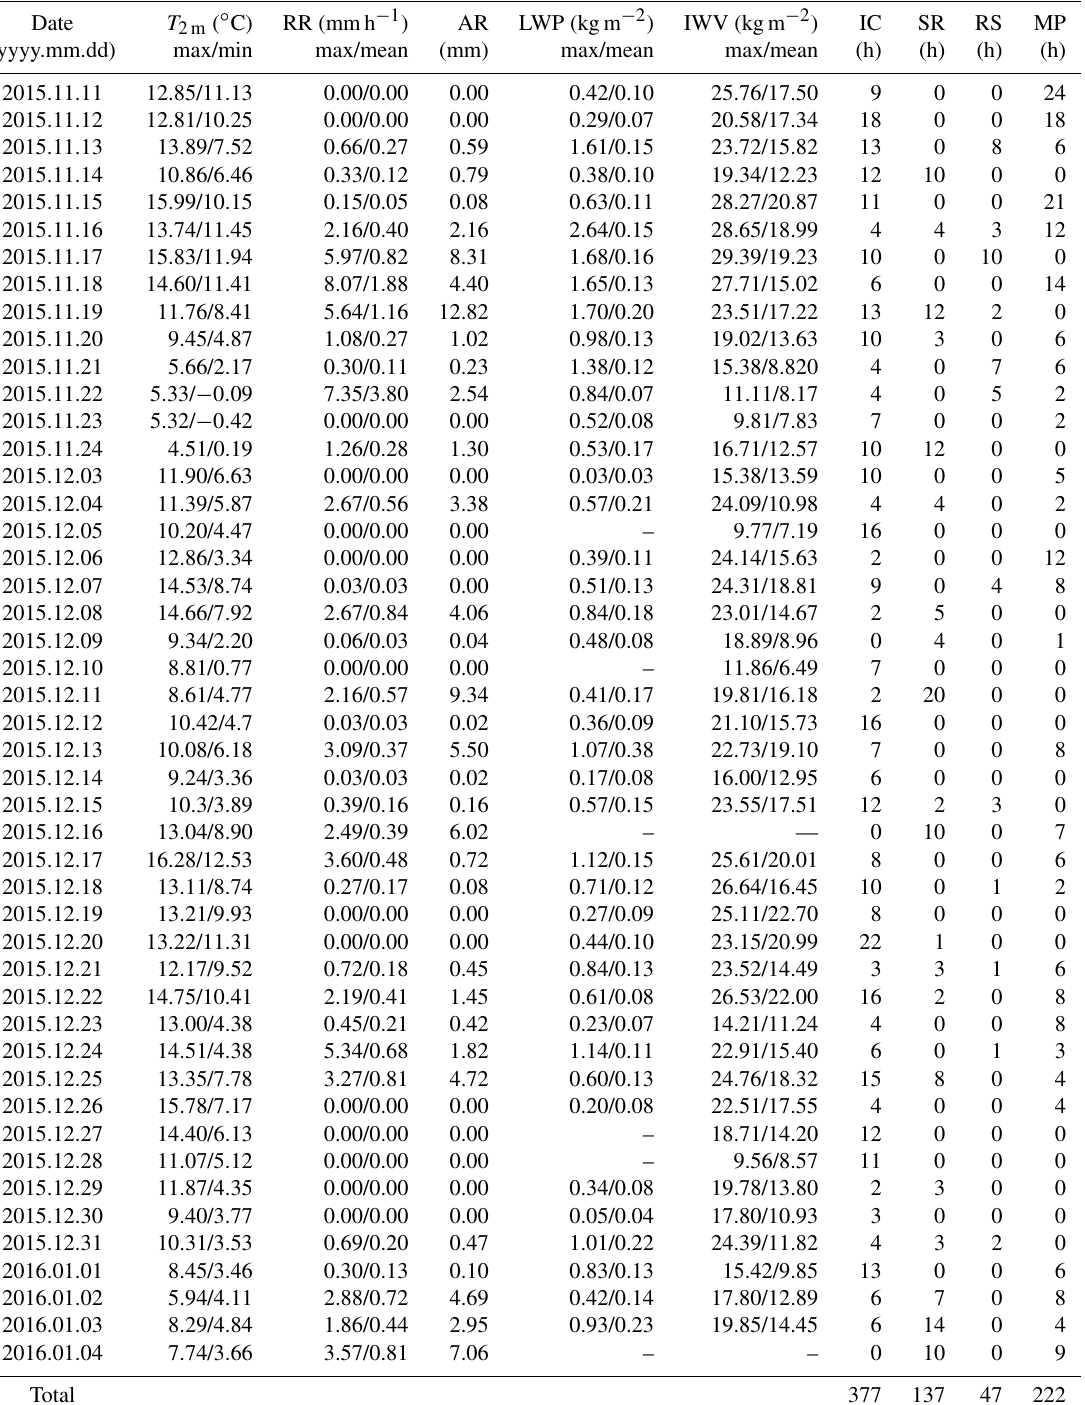
Table 6. Characterization of the atmospheric conditions and estimated duration of cloud and precipitation events during TRIPEx. T 2m is the air temperature at 2m from a nearby weather station. RR and AR are the rain rate and the accumulated rain measured by a Pluvio disdrometer; mean RR is calculated using all RR values larger than 0mmh − 1 . Liquid water path (LWP) and integrated water vapor (IWV) are derived from the collocated 14-channel microwave radiometer; mean LWP is calculated using all LWP values larger than 0.03kgm − 1 in order to exclude clear-sky periods. The columns with IC, SR, RS, and MP indicate the approximate duration in hours of non-precipitating ice clouds, stratiform rain, rain showers, and shallow mixed-phase clouds,